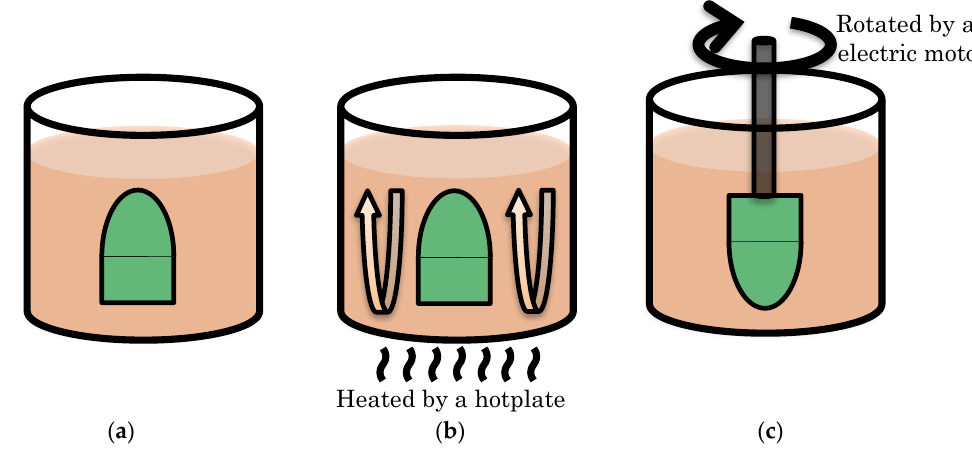
Figure 3. Schematic depictions of dipping methods. ( a ) Static dipping; ( b ) Convectional dipping; ( c ) Rotational dipping.